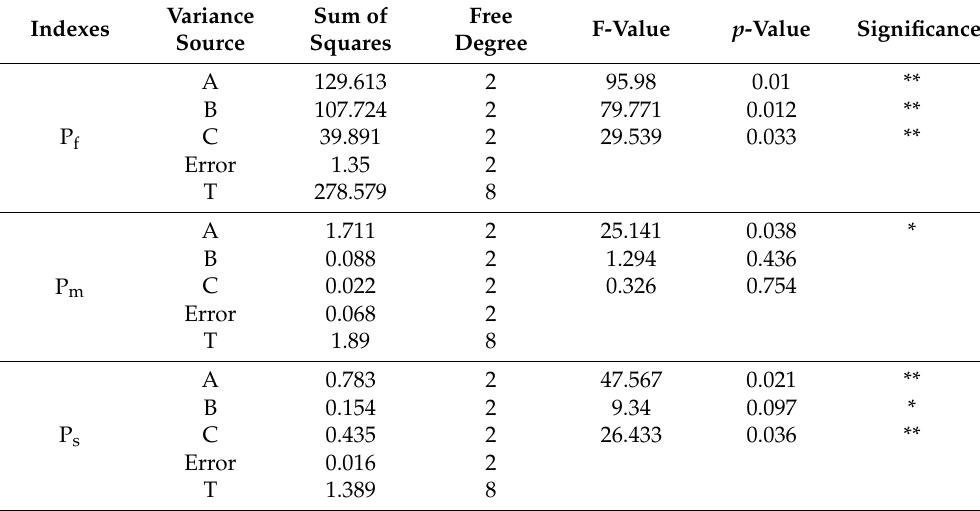
Figure 5. Range analysis of unpressed vines experiment results; ( a ) P m , ( b ) P s , ( c ) P f. Table 4. Experimental variance analysis of unpressed vines.